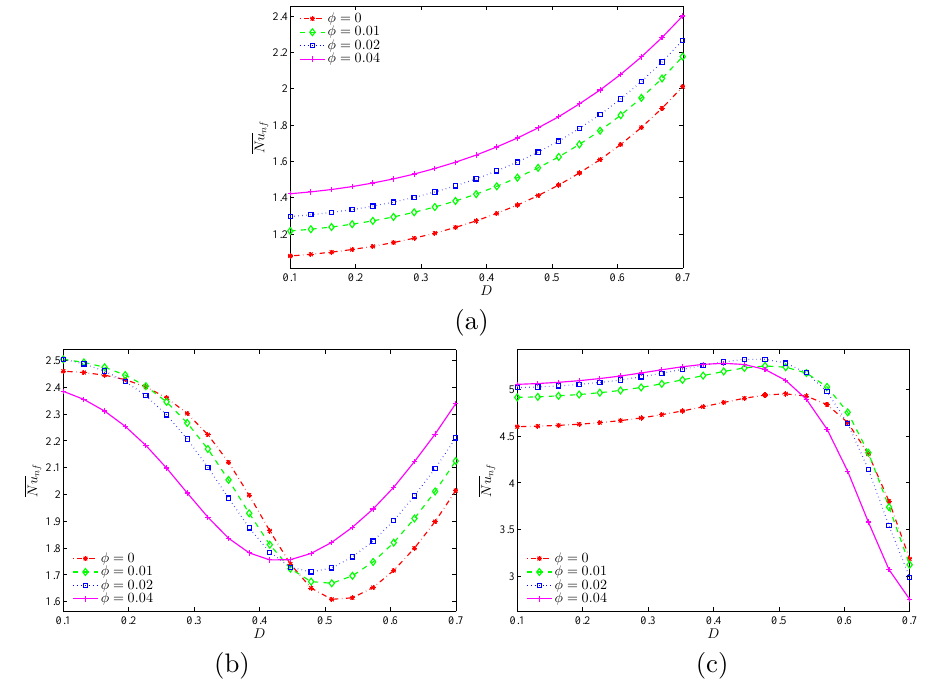
Figure 19. Variations of average Nusselt numbers with D for different φ for ( a ) Ra = 10 2 , ( b ) Ra = 10 4 and ( c ) Ra = 10 5 at k w =